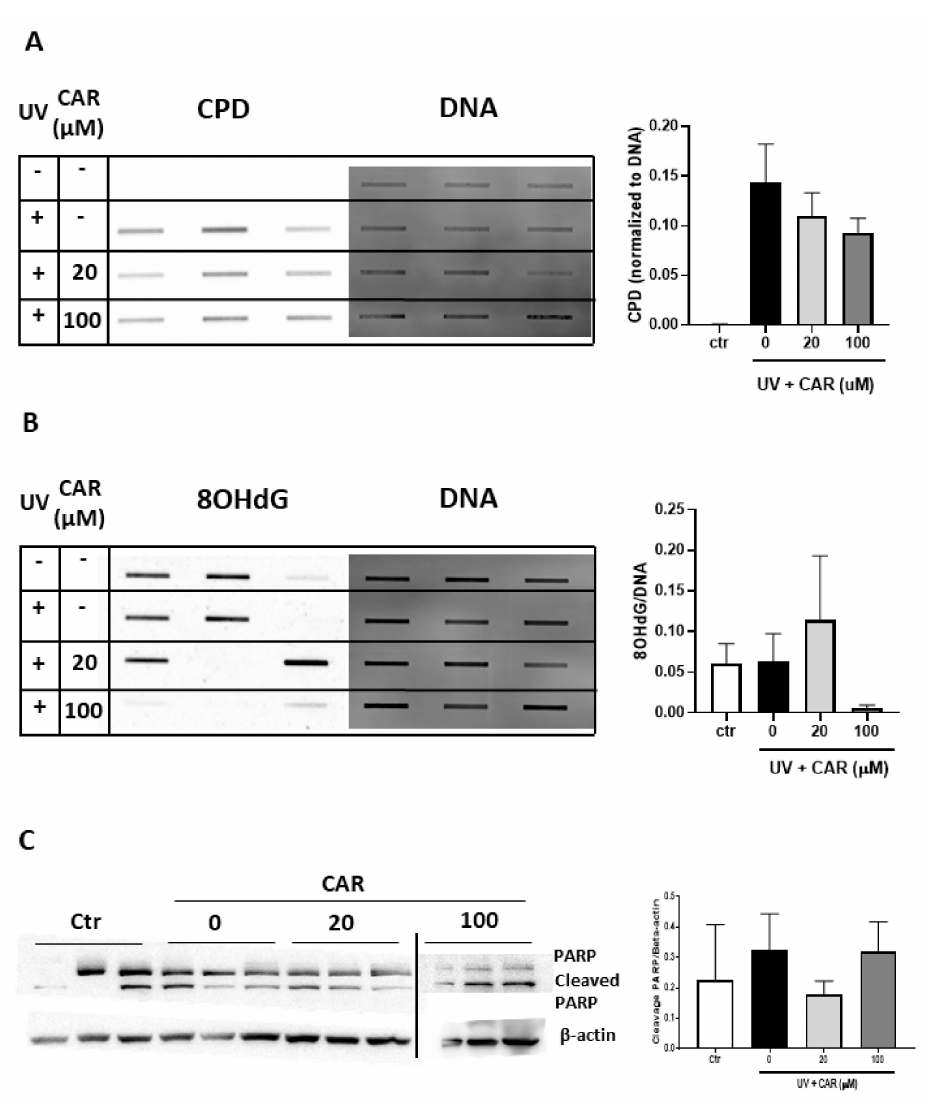
Figure 5. E ff ect of carvedilol on UV-mediated CPD and 8-OHdG formation and apoptosis in 3D human reconstituted skin (EpiDerm TM FT-400). The reconstituted human full thickness skin was treated with UV (200 mJ / cm 2 ), with or without carvedilol (CAR, 20, or 100 µ M), for 24 h (see Materials and Methods for details). Genomic DNA was isolated from the cultures and analyzed with the slot blot assay with the CPD antibody ( n = 3) ( A ) or the 8-OHdG antibody ( n = 3) ( B ). ( C ) Western blot analysis of PARP, cleaved PARP, and β -actin. The blot images are cropped from two full-length blots and put together. The two gels were run and processed in parallel. Bar graphs represent the ratios of cleaved PARP / β